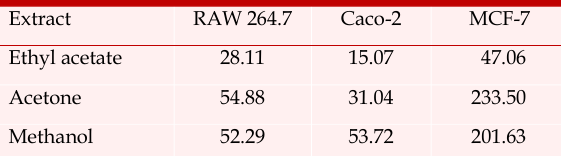
Cytotoxicity level of the extracts using MTT assay